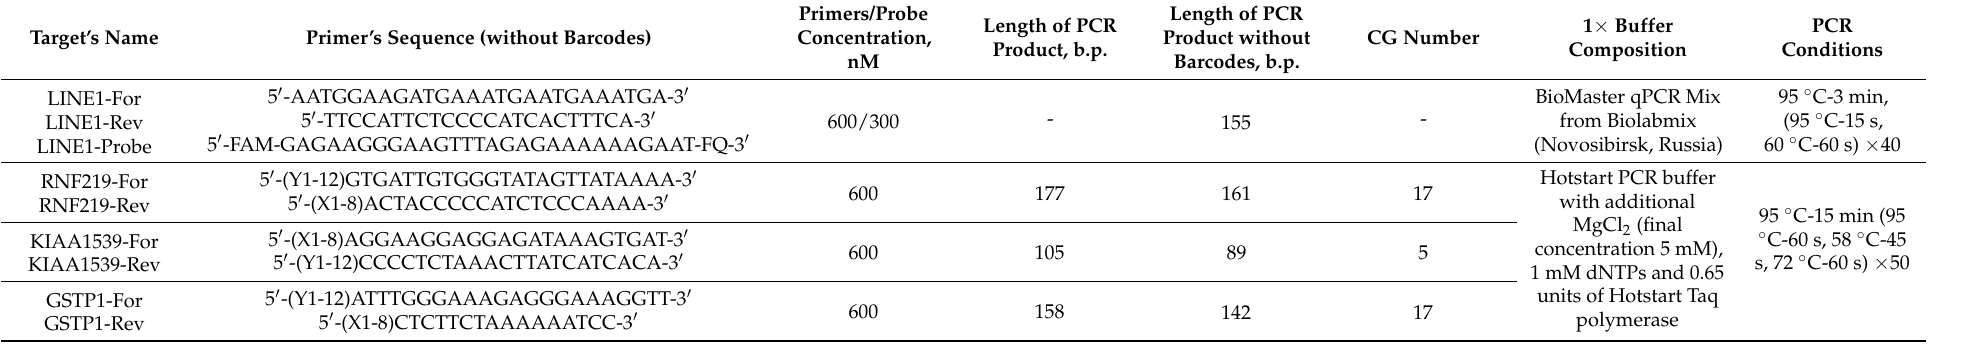
Table 2. PCR conditions and primer’s